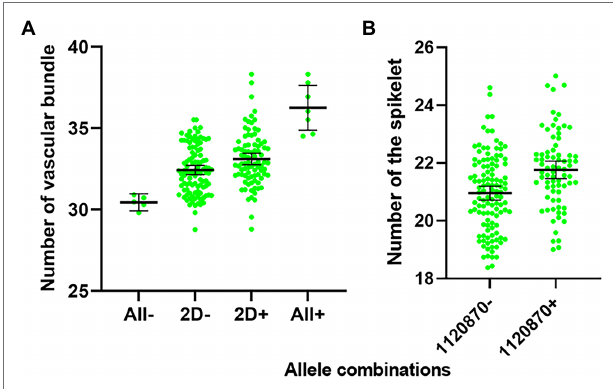
FIGURE 6 | Allele effects of VB alleles on the number of big vascular bundle (A) , and the number of the spikelet (B) . ALL-stands for all alleles for VB were absent; 2D-stands for allele on Chromosome 2D ( Qvb-2D ) was absent; 2D+ stands for allele on Chromosome 2D ( Qvb-2D ) was present; ALL+ stands for all alleles for VB were present. 1120870 is the nearest marker for Qvb-4B , 1120870- means 1120870 was absent; 1120870+ means 1120870 was present. Error bars in the figures indicate 95% confidence